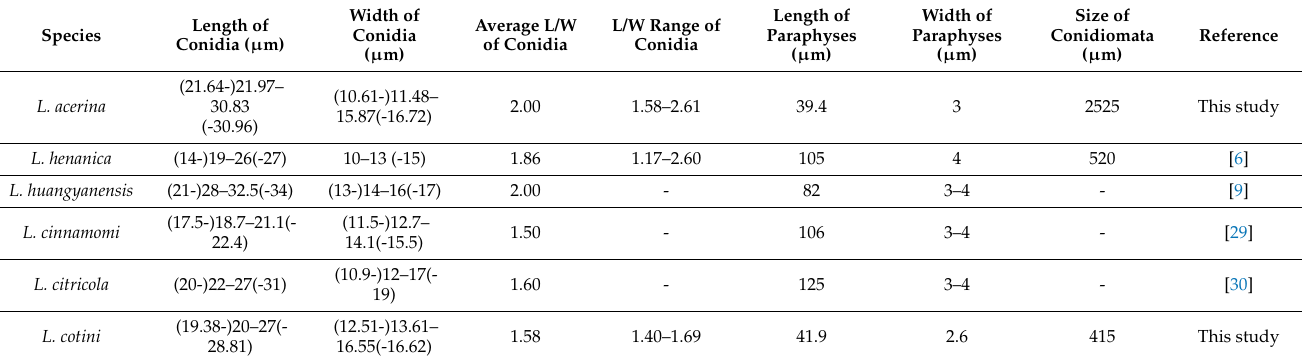
Table 2. Morphological characteristic comparison between L. acerina , L. cotini and their close